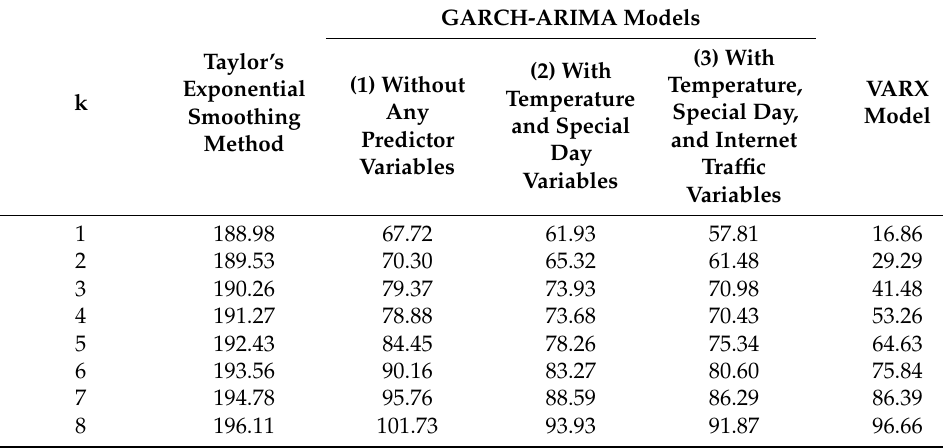
Table 8. Forecast performance evaluation by RMSE.